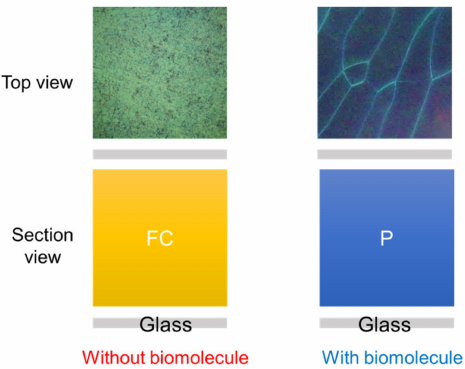
Figure 2. In the presence of abundant biomolecules on the DMOAP substrate, the configuration changes from a predominant reflection mode to a predominant transmission